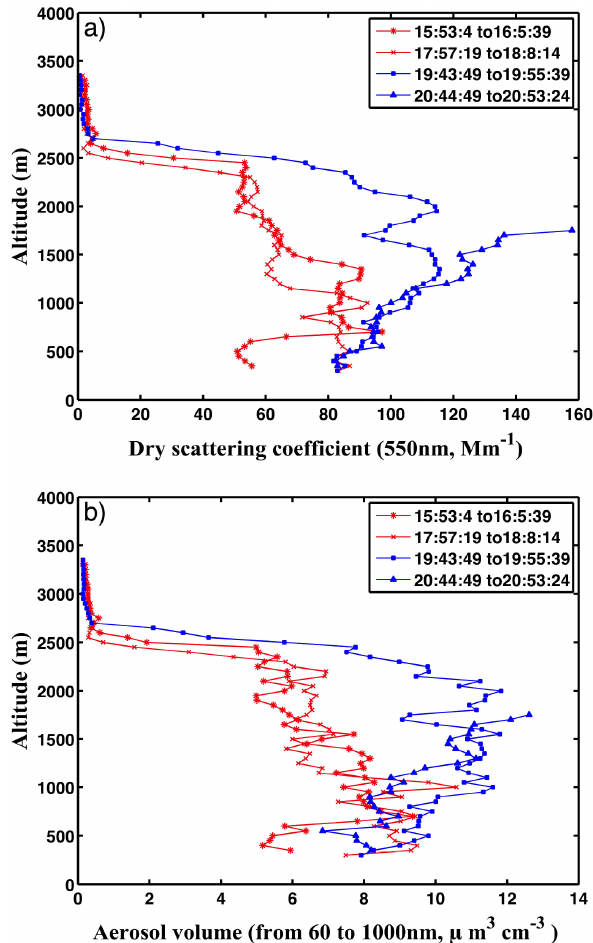
Figure 11. In situ measurements of dry scattering coefficient (a) and aerosol volume (b) from vertical profile flights from the NASA P3-B aircraft made over the DRAGON_Edgewood site on 10 July 2011. Two profile flights made before cumulus formation (in red) and two afterward (blue) are shown. The time series of the AOD and lidar backscatter for this same site and date are shown in Fig. 9c.